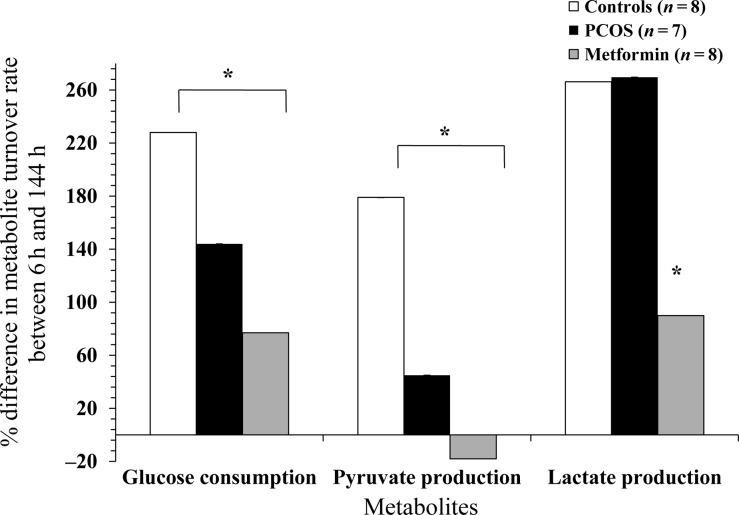
The effects of aetiology on percentage increase (positive values) or decrease (negative values) in glucose consumption and pyruvate and lactate production rate per 1 × 105 viable GCs per well over 144 h of culture. The values plotted are mean ± SEM of the data for the number of individual patient cultures shown. Asterisk indicates significant difference (P < 0.05) between the aetiologies for the metabolite shown.